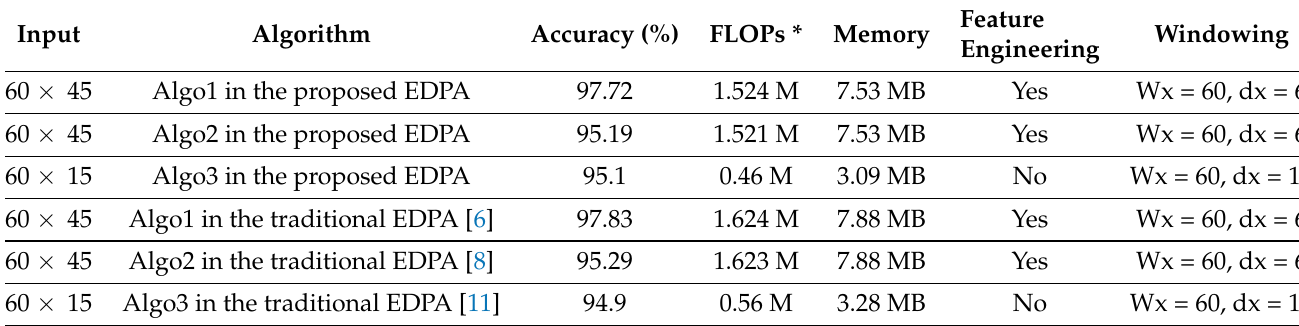
Table 4. Driver identification algorithms with their specifications.